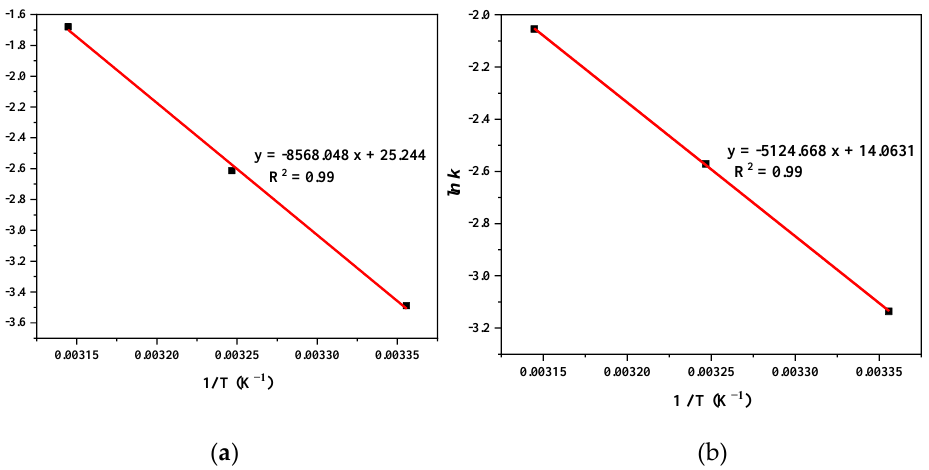
Figure 7. Arrhenius plot of phenol degradation on (a) octahedral Mn 3 O 4 (b) Mn 3 O 4 -NPs catalyst.